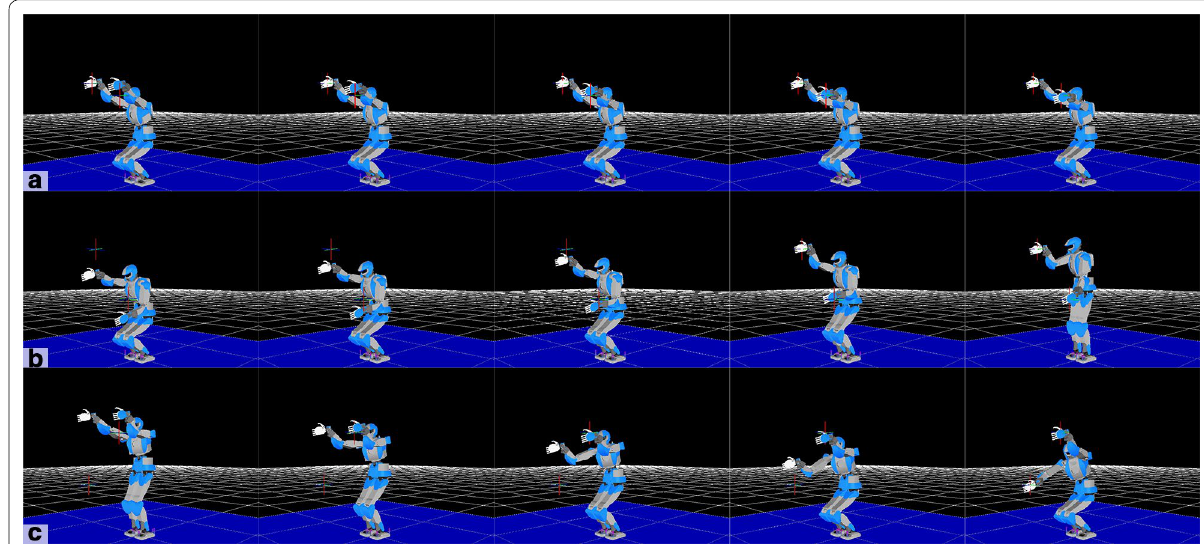
Fig. 15 The simulation result when approaching random target positions. These movements include whole-body motion in the vertical direction and the arms’ motion in the vertical and diagonal direction ( a , b , and c show the movement with different target positions)